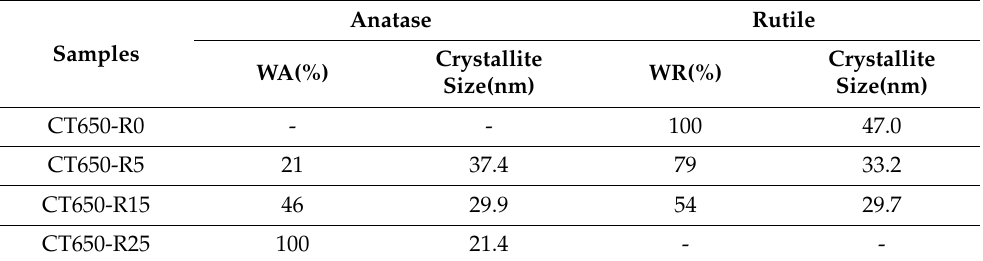
Table 1. The weight fractions and crystallite sizes of rutile and anatase phases of CT650-R0, R5, R15 and R25.